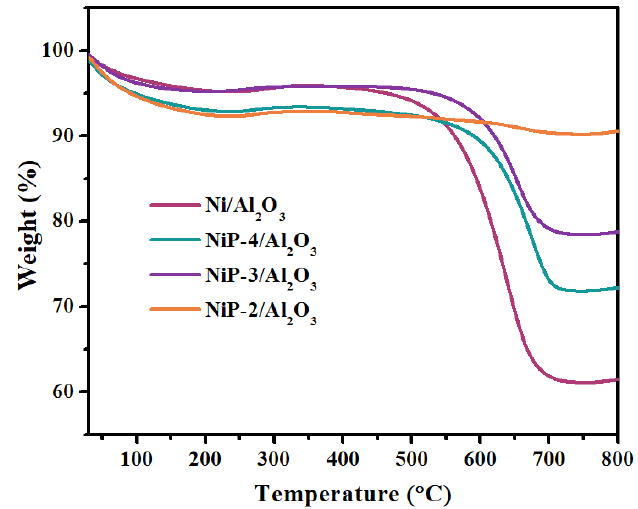
Figure 8. TG profiles of spent Ni/Al 2 O 3 and NiP-x/Al 2 O 3 catalysts.